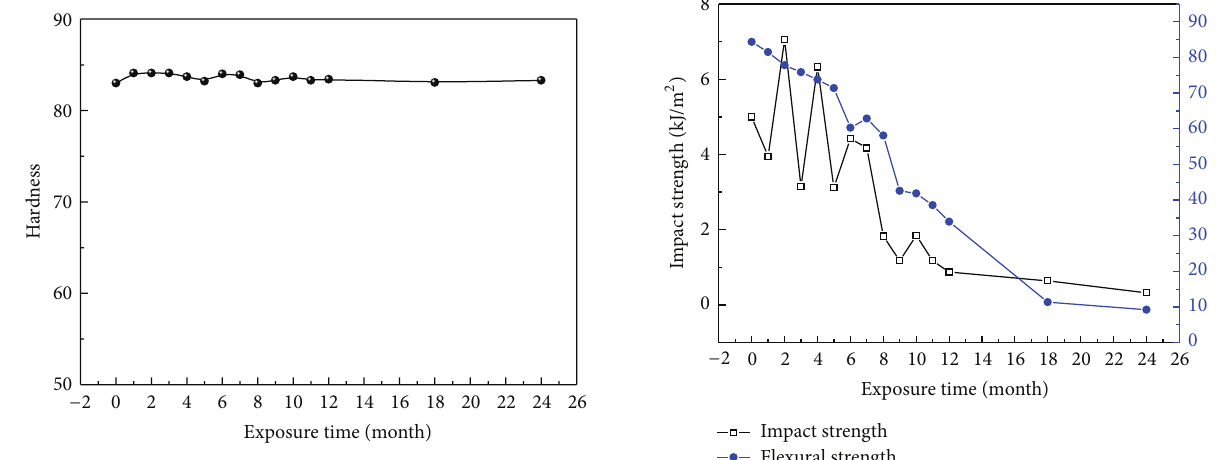
Figure 3: Relationship between exposure time and the hardness of PS under the environment of Xisha Island.